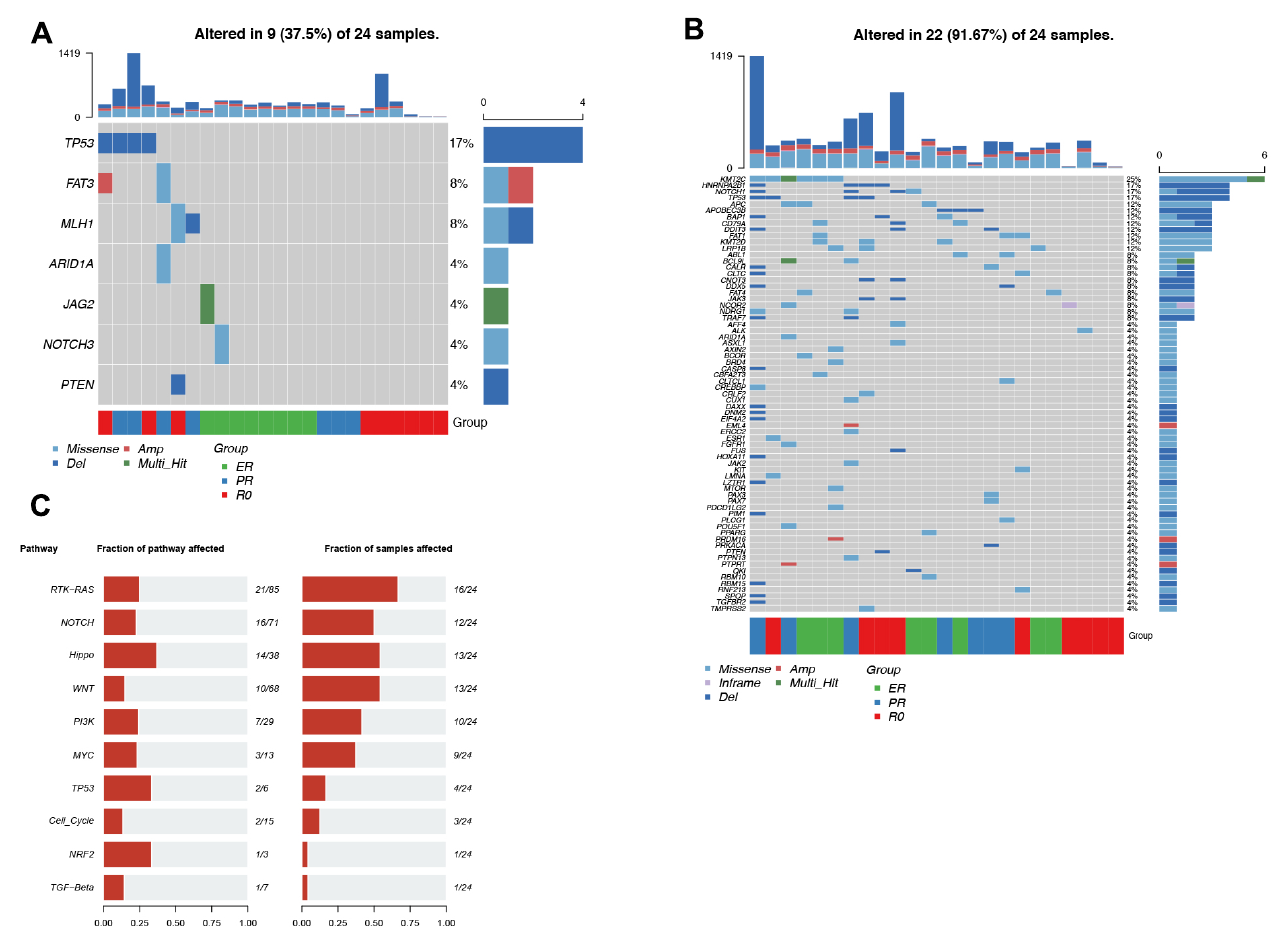
Figure 1. Somatic alterations were identified in 24 EV-DNA samples. The plots show the presence of alterations in cancer-associated and cancer-hallmark genes, and the most frequently altered pathways. ( A ) Oncoplot showing the frequency of each type of somatic alteration in ovarian cancer genes. Each column represents one sample. Patient groups are represented by the colored bars at the bottom, labeled “Group.” ( B ) Oncoplot showing the somatic alterations identified in cancer-hallmark genes. ( C ) Barplots showing the altered oncogenic pathways. Left: The fraction of genes altered in the pathways. Right: The fraction of EV-DNA samples carrying alterations in the pathways. ER = excellent response to neoadjuvant chemotherapy (NACT); PR = poor response to NACT; R0 = no residual disease; EV = extracellular